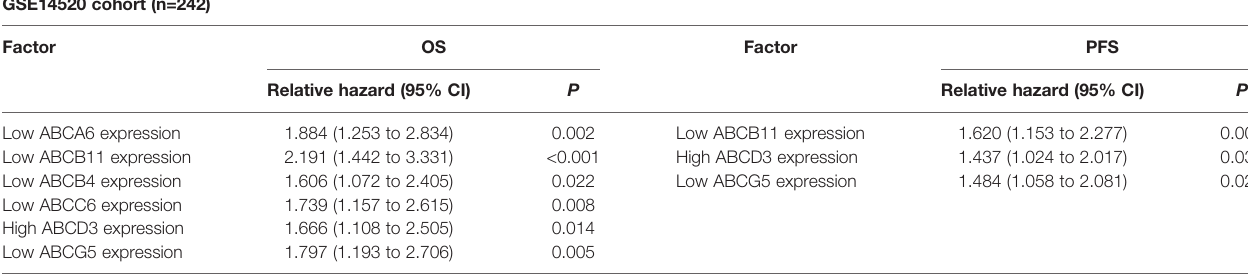
TABLE 1 | Cox regression analysis of ABC family genes in GSE14520 cohort.